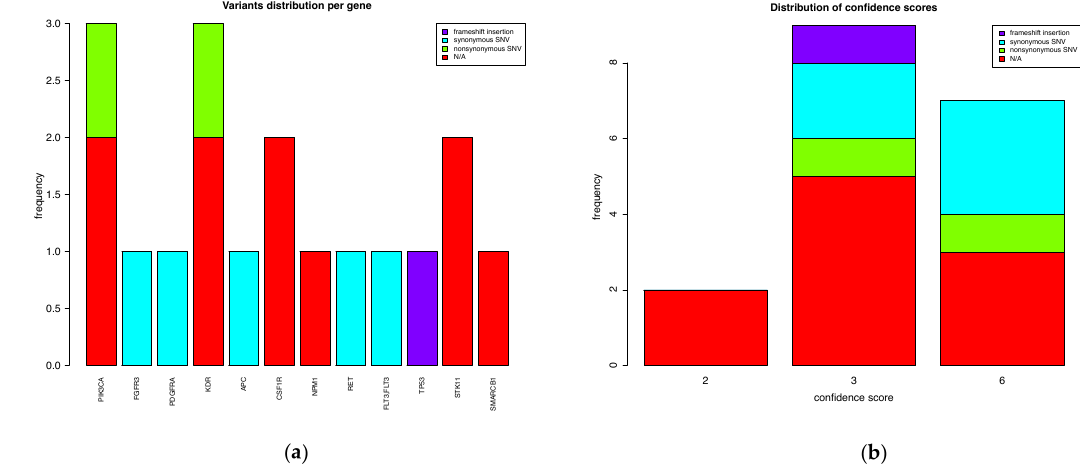
Figure 3 Figure 3. An example of VARIFI output plots. ( a ) Variant distribution on genes. In this example, the exonic function for most variants was not available (“N/A”) since the variants were found in the intronic and UTR3 regions, and the highest number of variants was found on PIK3CA and KDR genes, three variants on each gene. Five variants were synonymous single-nucleotide variants (SNVs), two variants were nonsynonymous SNVs and one variant was a frameshift insertion. ( b ) Distribution of variants based on their confidence score. Nine variants had a confidence score of 3, seven variants had a confidence score of 6 and two variants had a confidence score of